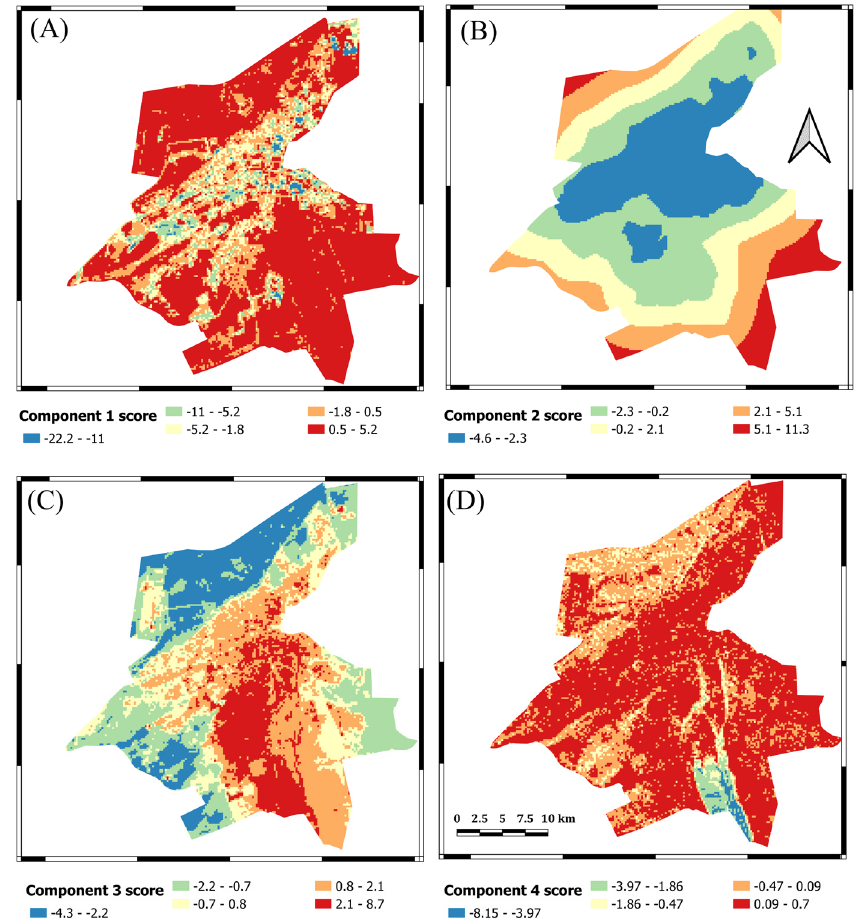
Figure 5. The four component scores: ( A ) effect of land use indicator, ( B ) infrastructure facility indicator, ( C ) ecological indicator, and ( D ) slope indicator.